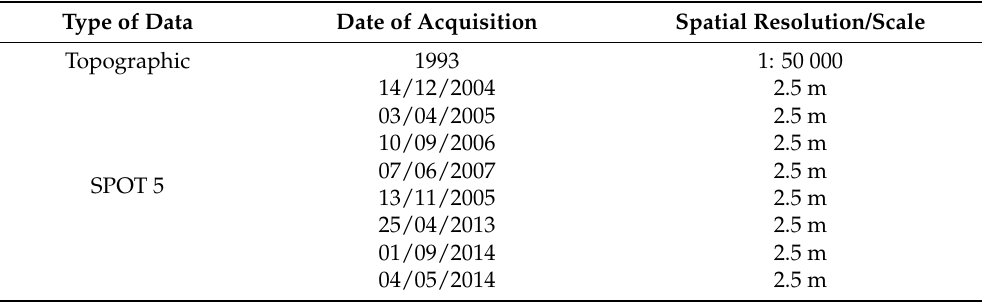
Table 2. Data sources according to the type of data, data acquisition, and spatial resolution/scale. Type of Data Date of Acquisition Spatial Resolution/Scale